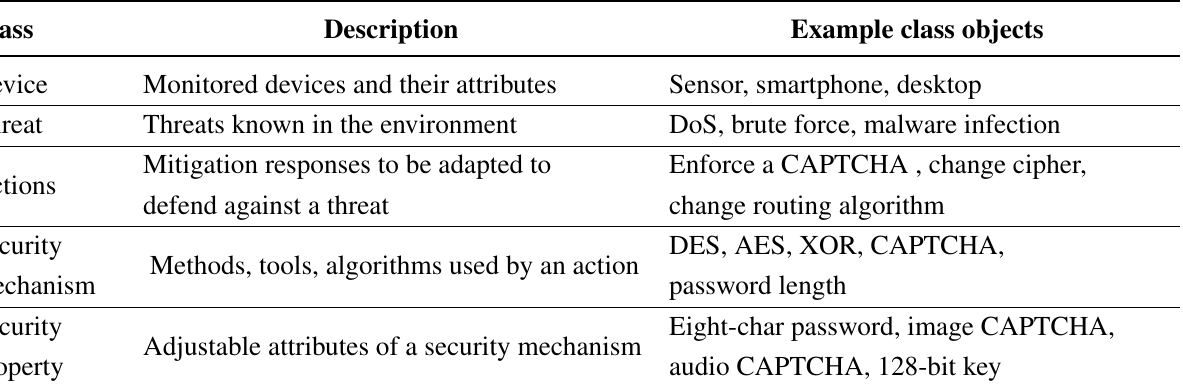
Table 2. Classes description in the adaptation